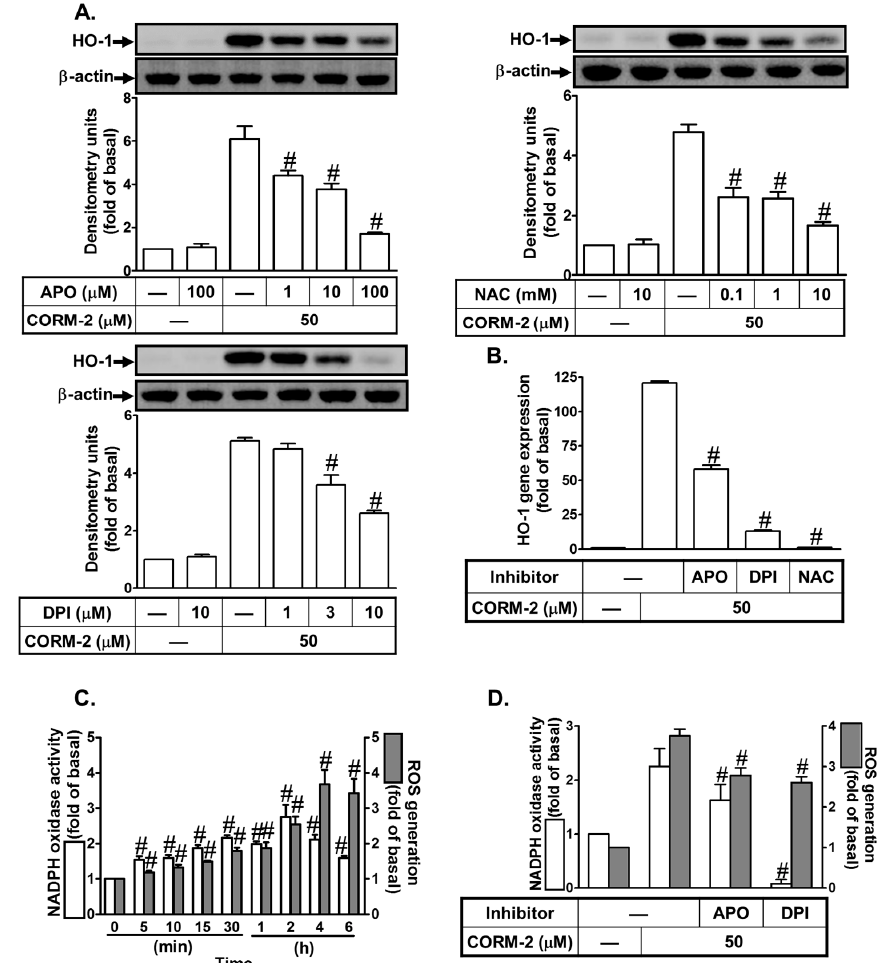
Figure 3. CORM-2 induces HO-1 expression via Nox/ROS. ( A ) HPAEpiCs were pretreated with APO, DPI, or NAC for 2 h and then incubated with CORM-2 for 16 h. The protein levels of HO-1 and β -actin were determined by western blot. ( B ) Cells were pretreated with APO (100 µ M), DPI (10 µ M), or NAC (10 mM) for 2 h and then incubated with CORM-2 for 6 h. The mRNA expression of HO-1 was determined by real-time PCR. ( C ) Cells were treated with CORM-2 for the indicated time intervals. Nox activity and ROS generation were measured. ( D ) Cells were pretreated with APO (100 µ M) or DPI (10 µ M) and then incubated with CORM-2 for 2 h or 4 h. Nox activity and ROS generation were measured. Data are expressed as mean ± S.E.M. of three independent experiments ( n = 3). # p < 0.01, as compared with the cells exposed to the vehicle alone ( C ) or CORM-2 alone ( A , B , D